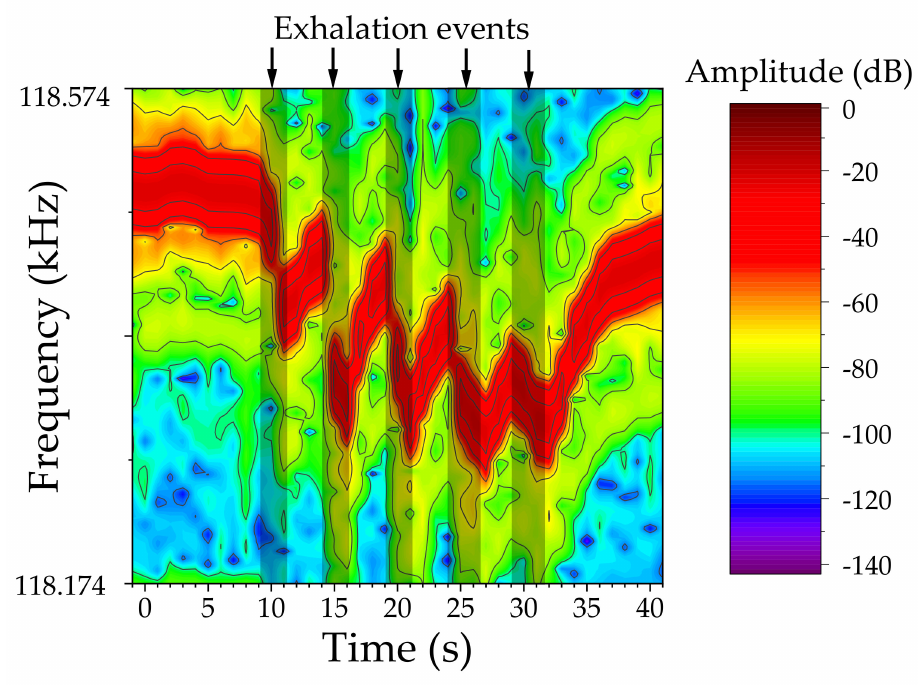
Figure 10. Breath detection test, the resonance frequency (red area) shifts to lower values as a response to exhalation events.